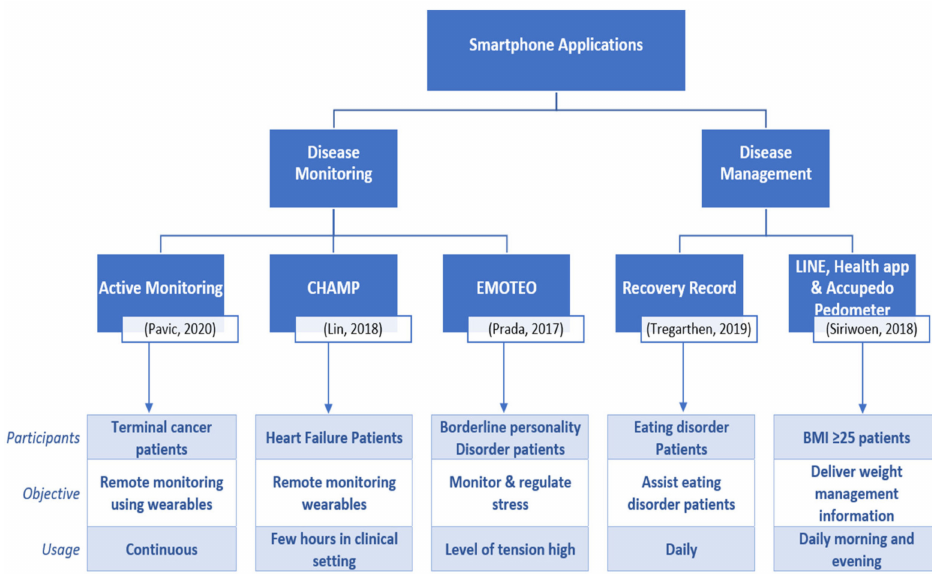
Figure 2. App functionalities and